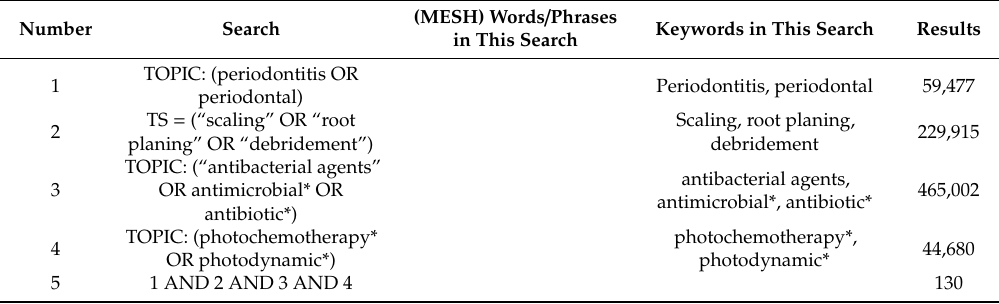
Table A2. Search strategy used for the Web of Science Core Collection.